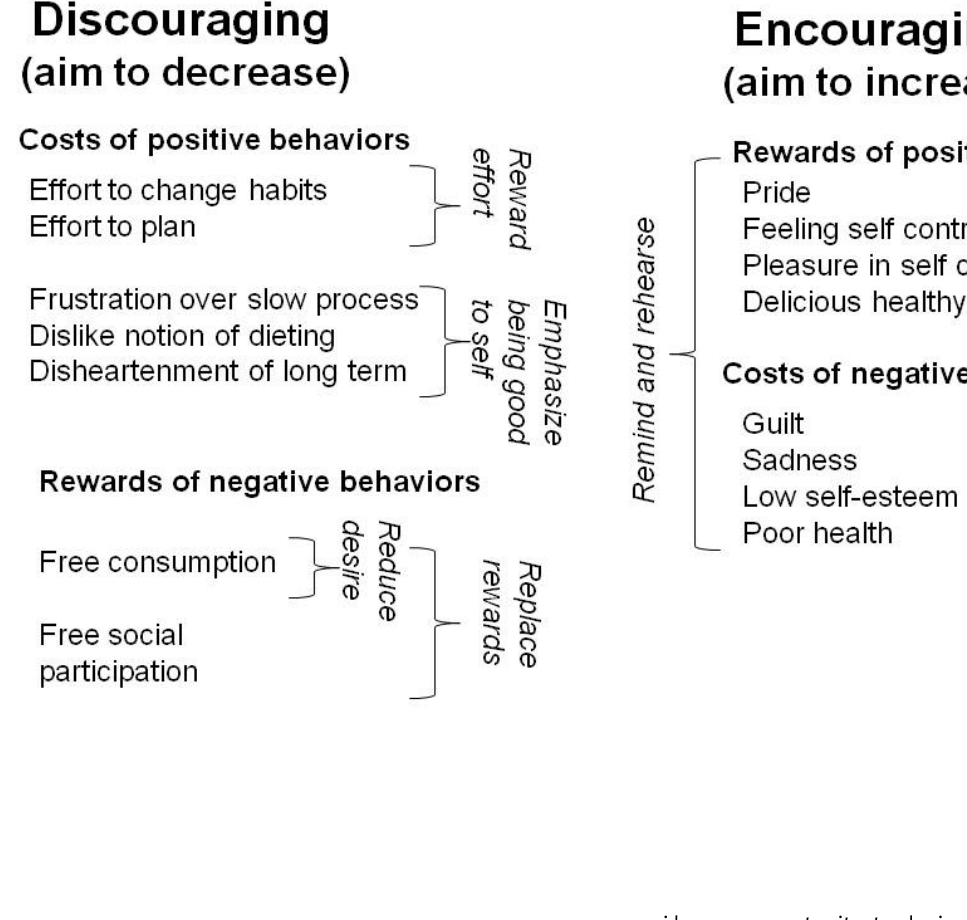
Figure 4. A summary of psychological constructs relevant to weight